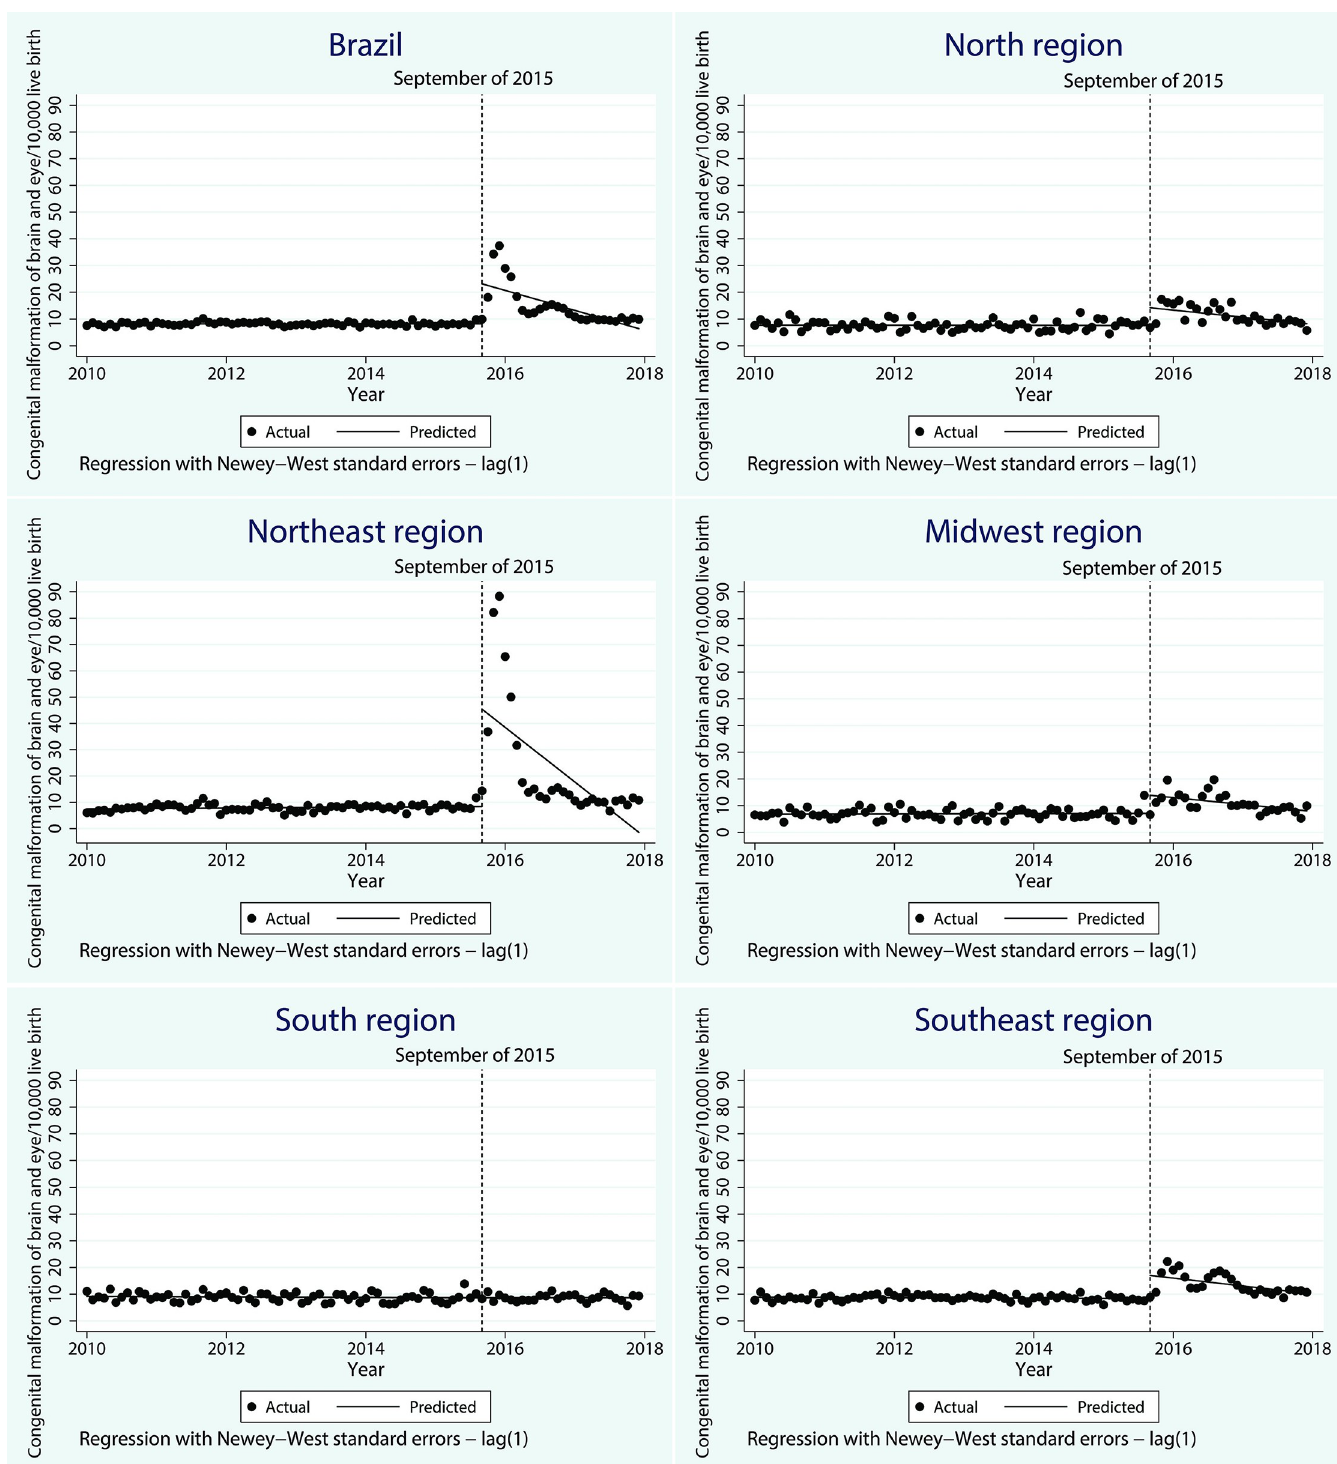
Fig 1. Time series of brain and eye congenital anomalies in Brazil and regions from 2010–2017.